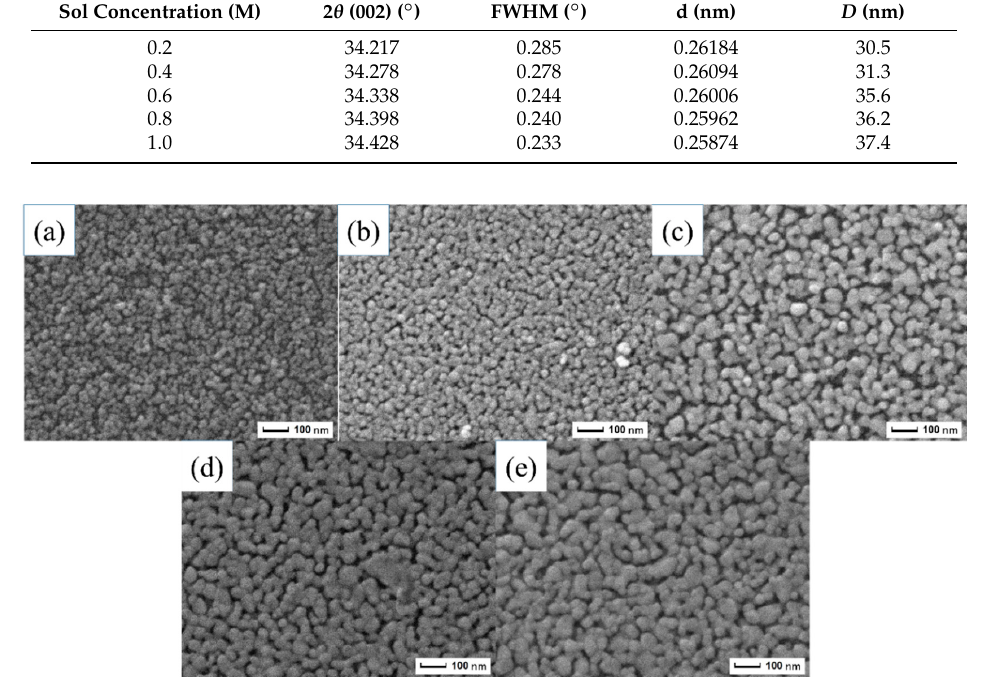
Figure 7. Scanning electron microscopy (SEM) images of the ZnO films at different sol concentrations: ( a ) 0.2 M, ( b ) 0.4 M, ( c ) 0.6 M, ( d ) 0.8 M, and ( e ) 1.0 M.